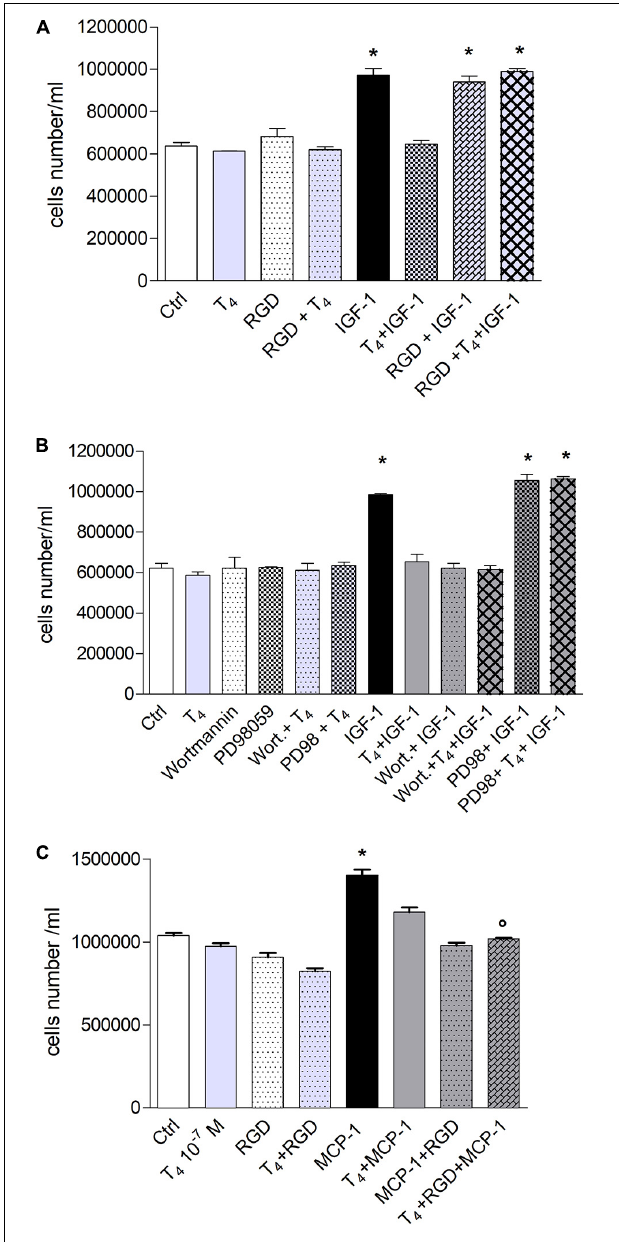
FIGURE 6 | Effect of T 4 on the proliferation of THP-1. (A) Effect of RGD on the proliferation of THP-1 cells, induced by insulin-like growth factor-1 (IGF-1) and IGF-1 + T 4 . RGD (10 µ M) was preincubated 20 min before T4 (10 − 7 M) and IGF-1 (10 − 8 M). Cells were counted 72 h after the stimulation. Results are reported as mean ± SD of n = 2 different experiments carried out in duplicate. * p < 0.001 vs. all others. (B) Role of mitogen-activated protein kinase (MAPK) and phosphoinositide 3-kinase (PI3K) pathways in THP-1 cell proliferation, induced by IGF-1 and IGF-1 + T 4 . PD98059 (10 µ M) and wortmannin (100 nM) were preincubated 20 min before adding T4 (10 − 7 M) and IGF-1 (10 − 8 M). Results are reported as mean ± SD of n = 3 different experiments carried out in duplicate. * p < 0.001 vs. all. (C) Effect of T 4 , monocyte chemoattractant protein 1 (MCP-1), MCP-1 + T 4 on the proliferation of THP-1 monocytes. RGD (10 µ M) was given to the cells 20 min before the hormone and MCP-1 and counted after 72 h from seeding at confluency. * p < 0.001 vs. all, ◦ p < 0.001vs. T 4 +